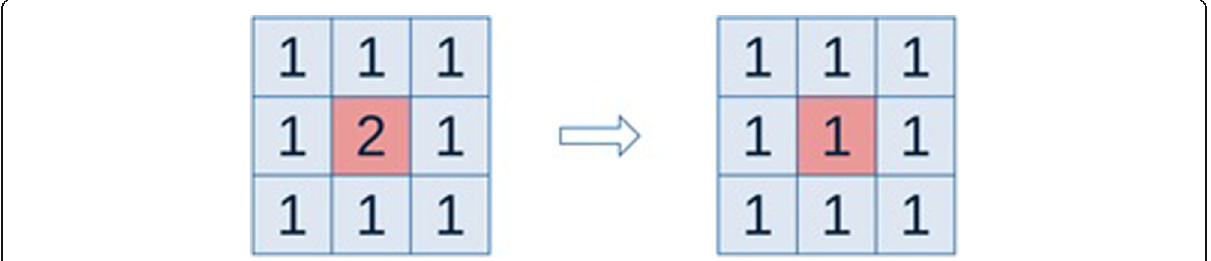
Fig. 2 Implementation process of Gaussian filtering